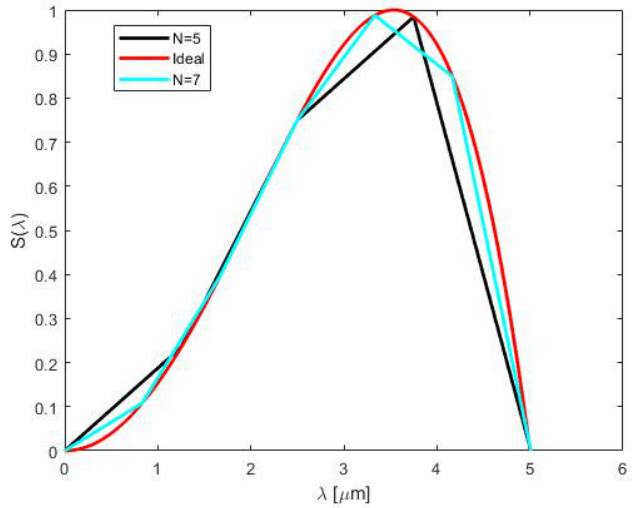
Figure 5. Spectral response function reconstruction with Hermite